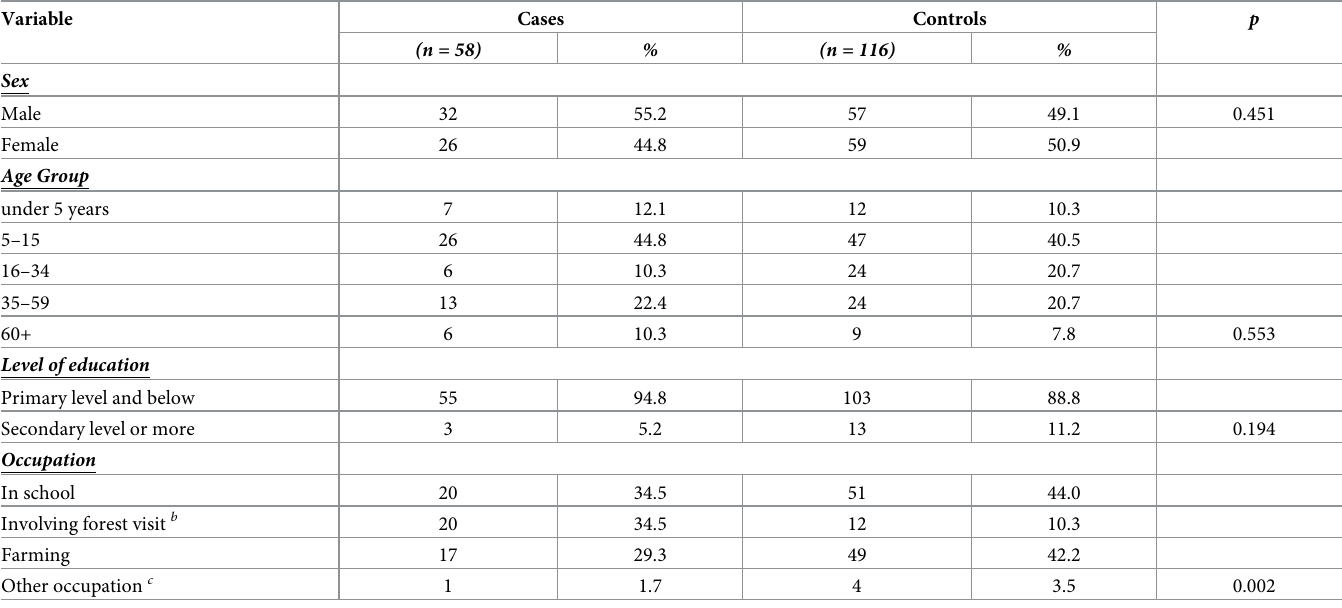
Table 2. Demographic characteristics of cases and controls in Gilgil, Kenya